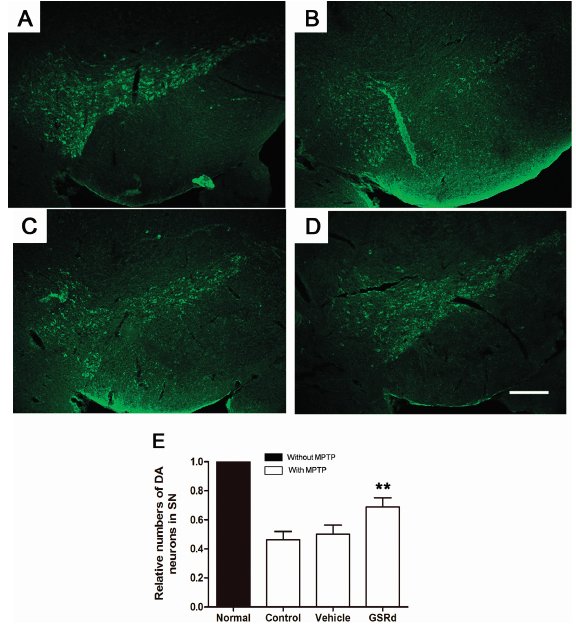
In C57BL/6J mice, MPTP administration resulted in a significant reduction of tyrosine hydroxylase (TH) positive dopaminergic neurons in SN (Figure 6A–D). GSRd treatment (10 mg/kg) prior to MPTP showed protection of TH + cells compared to MPTP and vehicle group (Figure 6E).